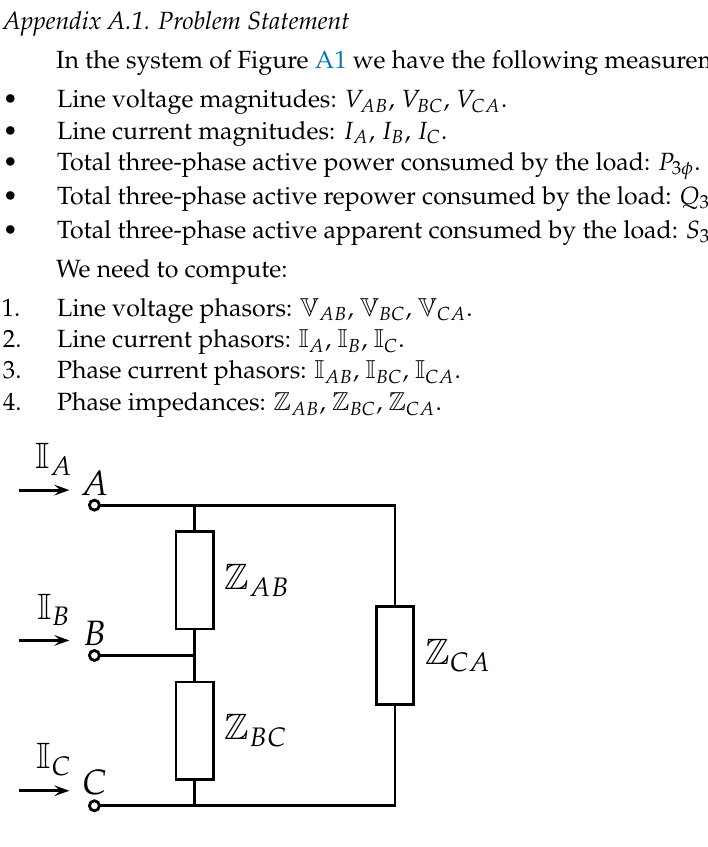
Figure A1. Problem statement.